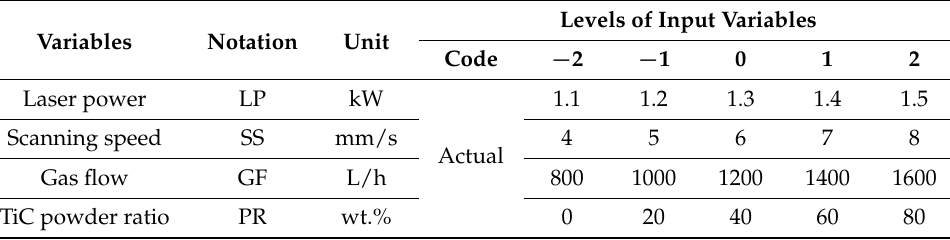
Table 3. Laser cladding processing parameter variables.